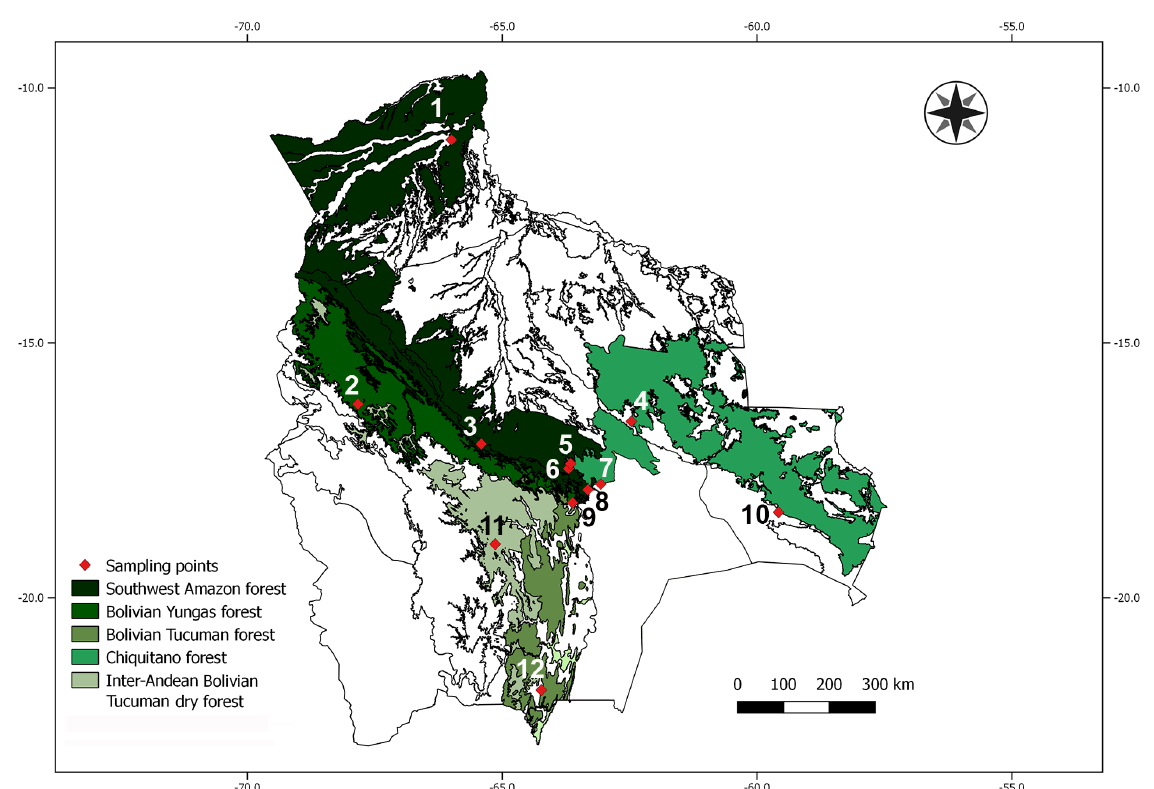
Fig. 1. Sampled locations and ecoregions according to the regionalization by Navarro & Ferreira (2011), map produced with QGIS (ver. 2.14.3, http://www.qgis.org/en/site/). 1 . Riberalta, Beni Dept. 2 .